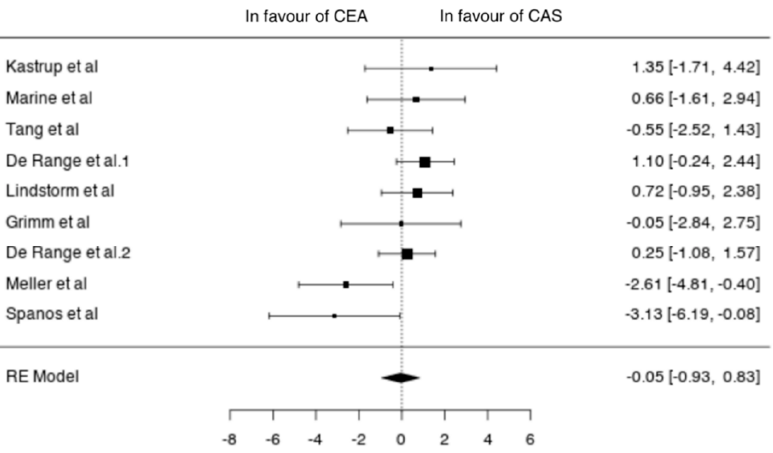
Figure 5. Differences in neurological events between the CEA and CAS groups in asymptomatic patients.